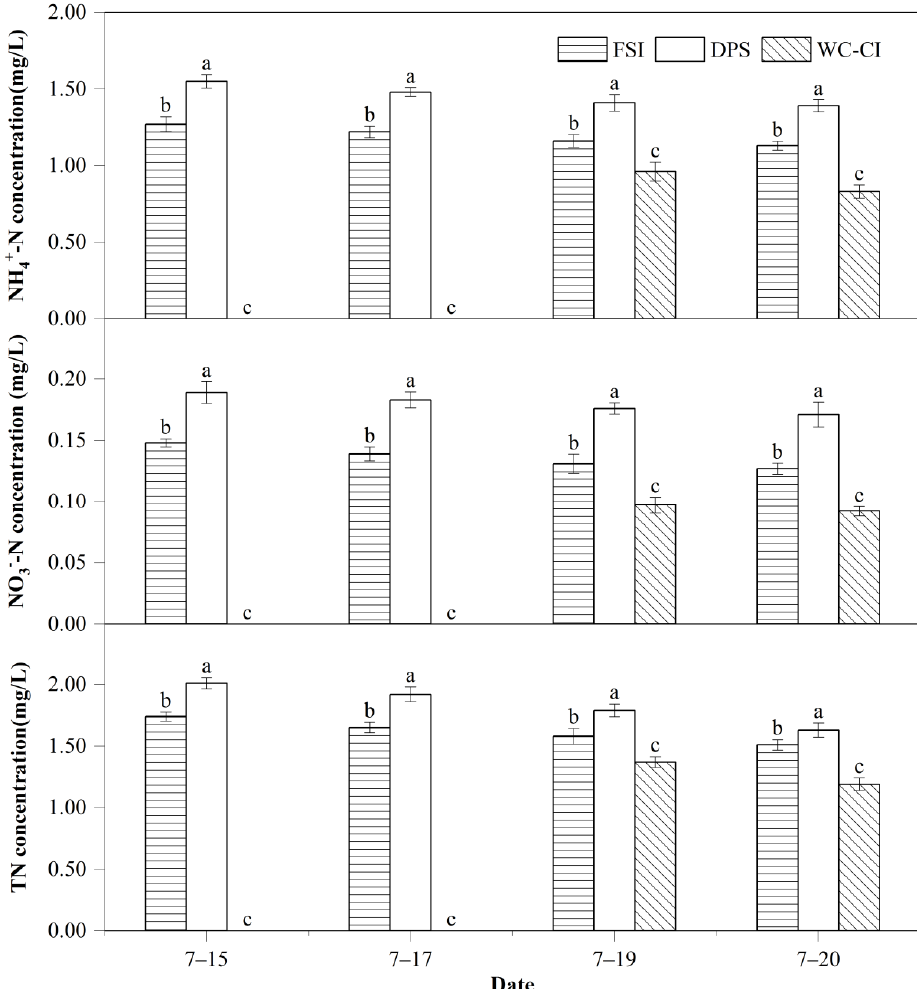
Figure 3. Variation of NH 4+ -N, NO 3 − -N and TN concentrations of surface drainage under different irrigation and drainage modes. (Note: The lowercase letters on the tops of columns in the figure represent significant difference among treatments at p < 0.05.).